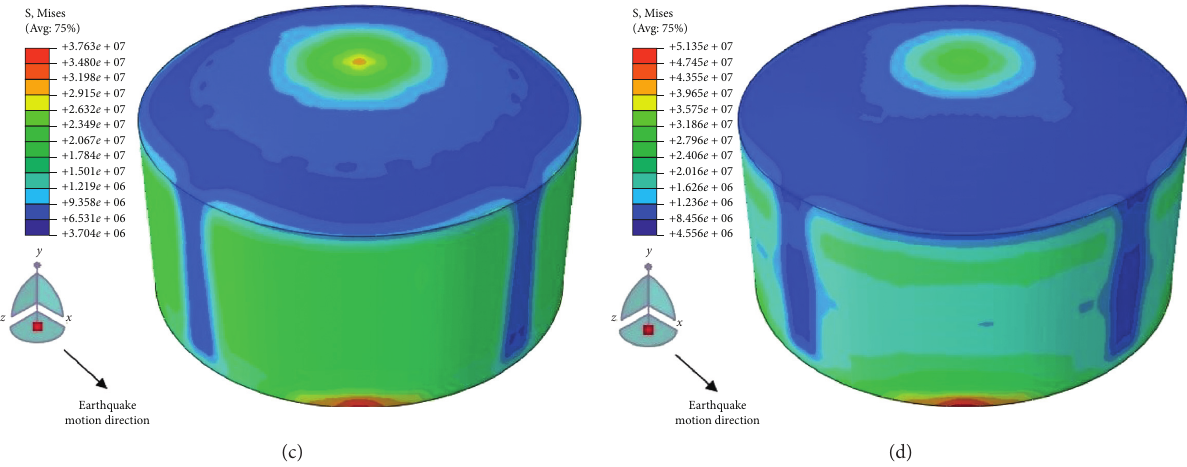
Figure 10: The maximum von Mises stress distribution of the outer tank at different LNG liquid levels. (a) At 25% full, (b) at 50% full, (c) at 75% full, and (d) at 100% full.